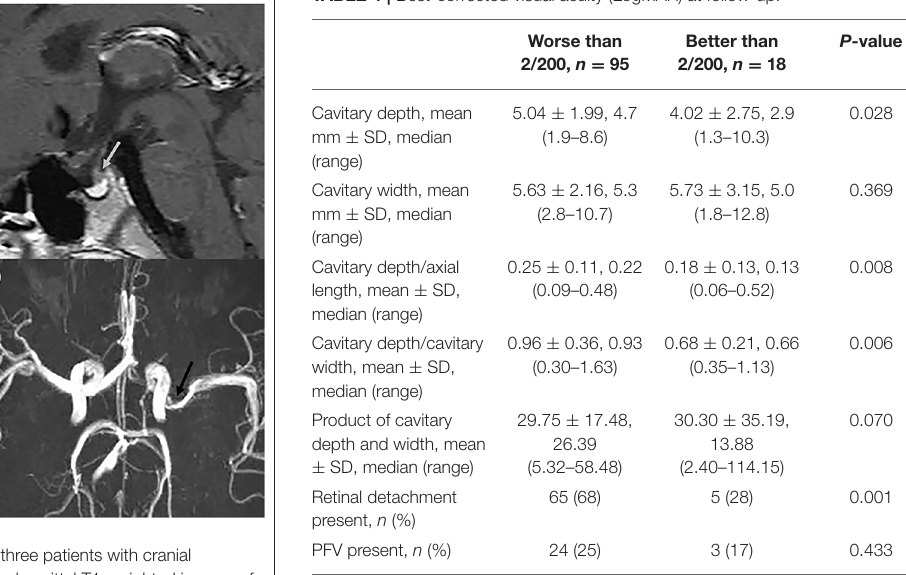
TABLE 4 | Best-corrected visual acuity (LogMAR) at follow-up.